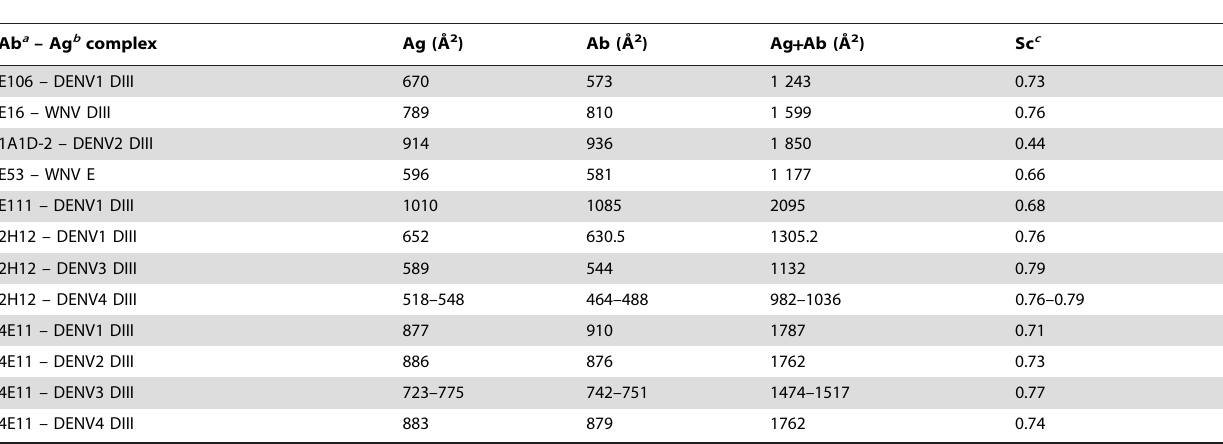
Table 2. DENV-1 DIII-E106 Fab structural